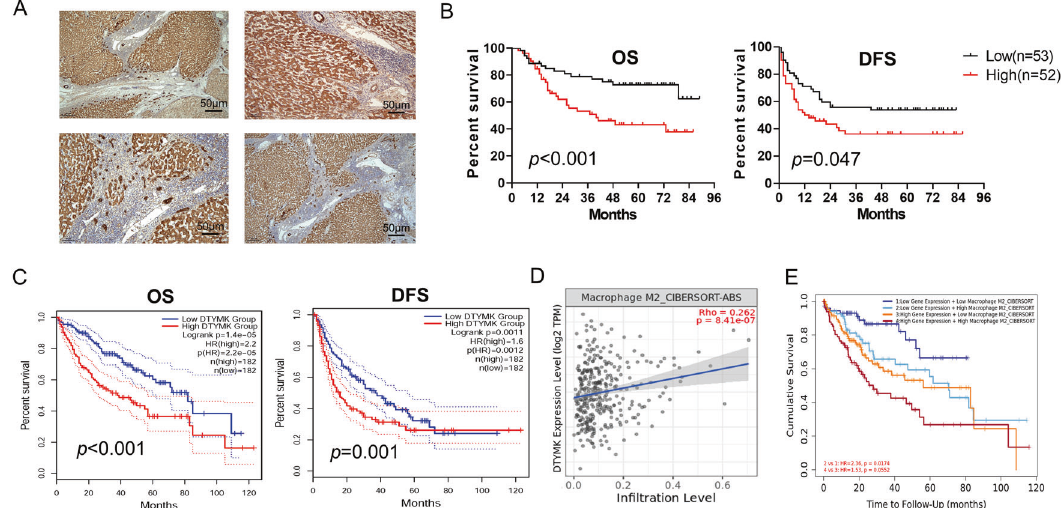
Fig. 5 DTYMK expression was signi fi cantly upregulated and associated with a poor prognosis. A Immunohistochemistry tests showing that DTYMK expression was signi fi cantly upregulated in HCC tissues. Scale bar = 50 μ m. B Increased expression of DTYMK was associated with poor OS and DFS among 105 patients with HCC from the Sun Yat-sen University Cancer Center. C Higher expression of DTYMK was associated with poor OS and DFS in HCC from TCGA. D and E DTYMK correlated with the in fi ltration of M2 macrophages and predicted the prognosis of patients with HCC more accurately. OS overall survival, DFS disease-free